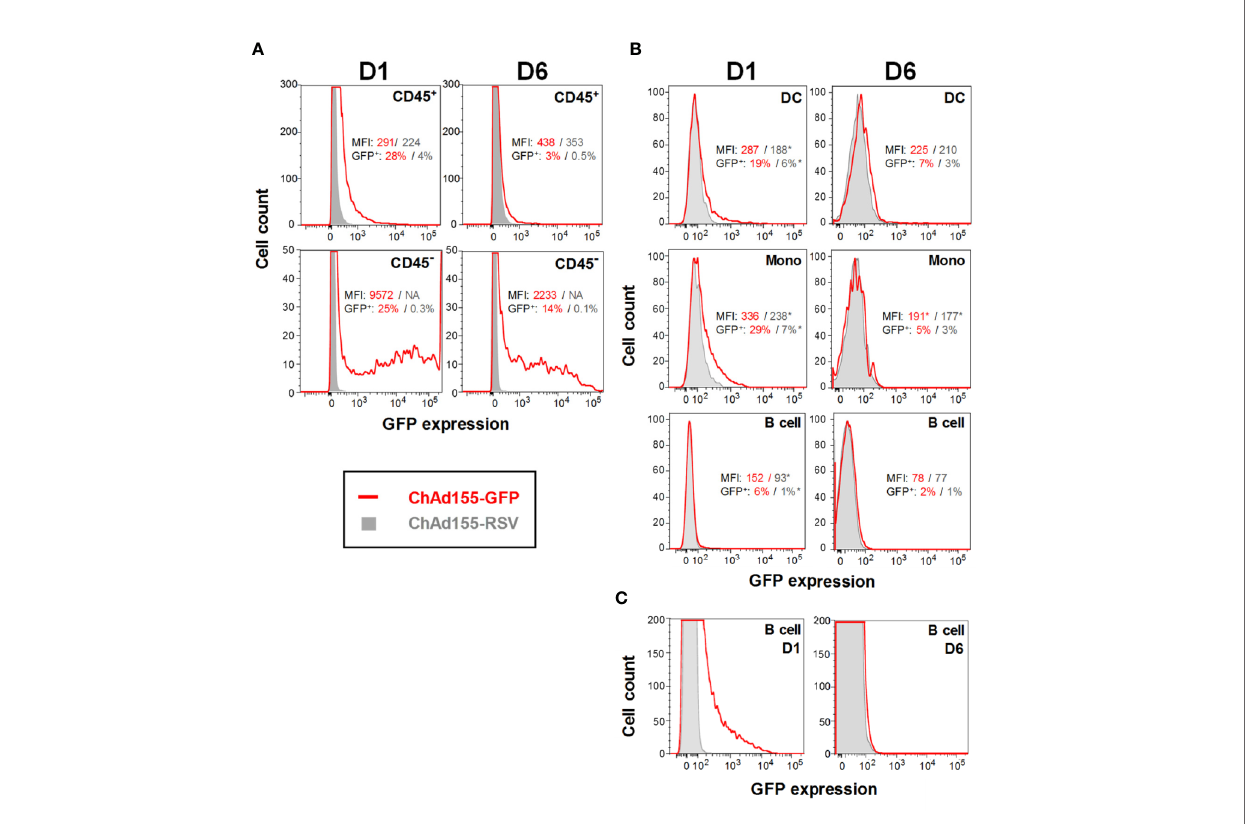
FIGURE 4 | Antigen expression and distribution in local cell populations after vaccination. Histograms representing green fl uorescent protein (GFP)-expressing cells detected in either hematopoietic (CD45 + ) or non-hematopoietic (CD45 − ) cell subsets in muscle cell suspensions (A) , or in immune-cell subsets in draining lymph node (dLN) cell suspensions (B) are shown. Given the loss of detail with the scaling of (B) which was needed to accommodate the different population sizes, a detail-zoom of the dLN B cells is presented in (C) . Mice were immunized with ChAd155-GFP or the control vaccine ChAd155-RSV (both at 5 × 10 9 vp; typically n = 5/time point). Injections were performed in both gastrocnemius muscles at 2.5 × 10 9 vp/muscle. Tissues were collected at 1 or 6 days post-immunization (D1, D6). Experiments were performed once (muscle) or in duplicate (dLN). Graphs represent data generated for a single representative animal. Geometric means of the mean fl uorescence intensity ( “ MFI ” ) values and of the frequencies of GFP-expressing ( “ GFP + ” ) cells measured in the ChAd155-GFP group (red font) and ChAd155-RSV group (grey font) are indicated in each graph; asterisks denote values that were calculated from only 1 or 2 samples (as MFI was not measured for samples with <50 positive events). DC, dendritic cells; including plasmacytoid DCs, resident DCs and migratory CD11b +/ − DCs. Mono, monocytes. B cell, CD19 + cell